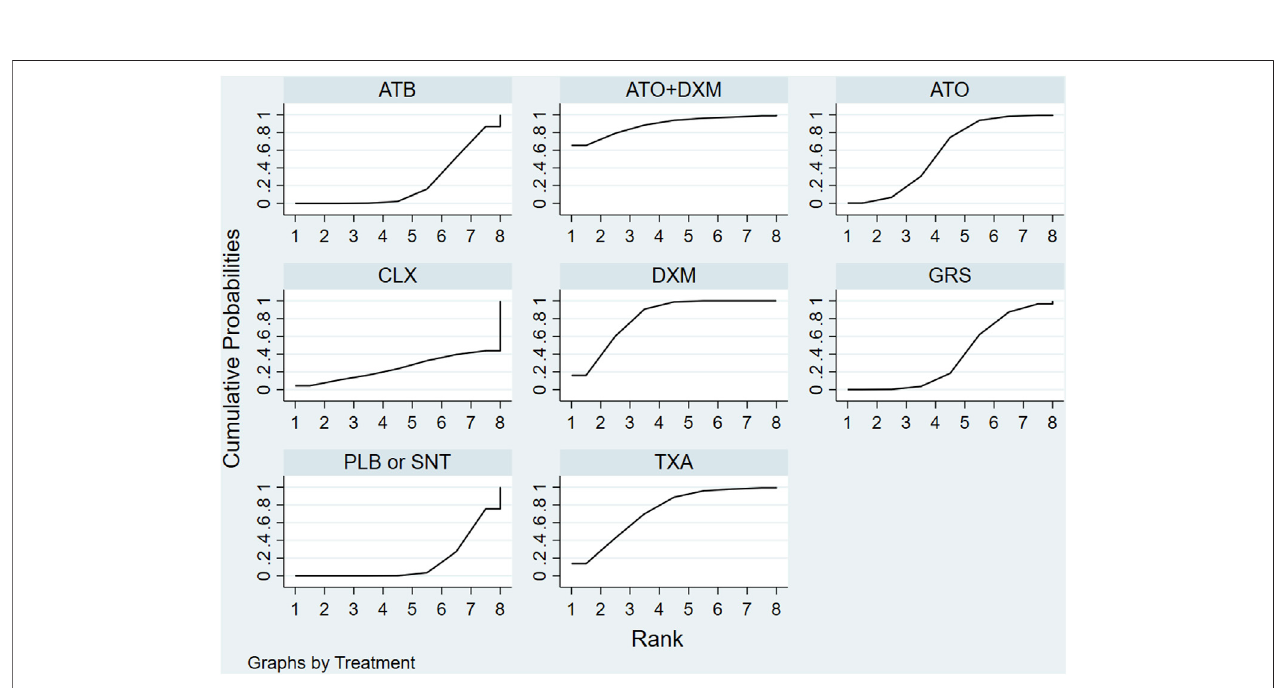
FIGURE 6 | SUCRA plot. The surface under the cumulative ranking curve (SUCRA) was generated to display a simple numerical statistical cumulative ranking probabilityplotofvariousinterventions.SUCRAis1iftreatmentiscertainlyatthehighestlevelorhighlyeffective,whilezeroifitundoubtedlymeansthatthetreatmenthas the worst effect. Abbreviations: TXA, tranexamic acid; DXM, dexamethasone; ATO, atorvastatin; GRS, goreisan; CLX, celecoxib; ATO+DXM, atorvastatin plus dexamethasone; ATB, antithrombotic; PLB or SNT, placebo or standard neurosurgical treatment; SUCRA, the surface under the cumulative ranking curve.